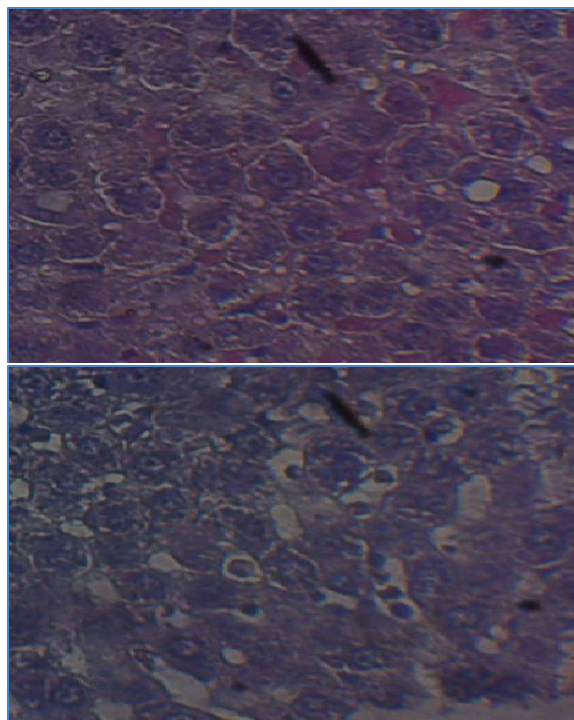
Figure, 4: Liver of DMH+Amg+M.W group. (Fibrosis, necrosis, hemorrhage and polymorphic